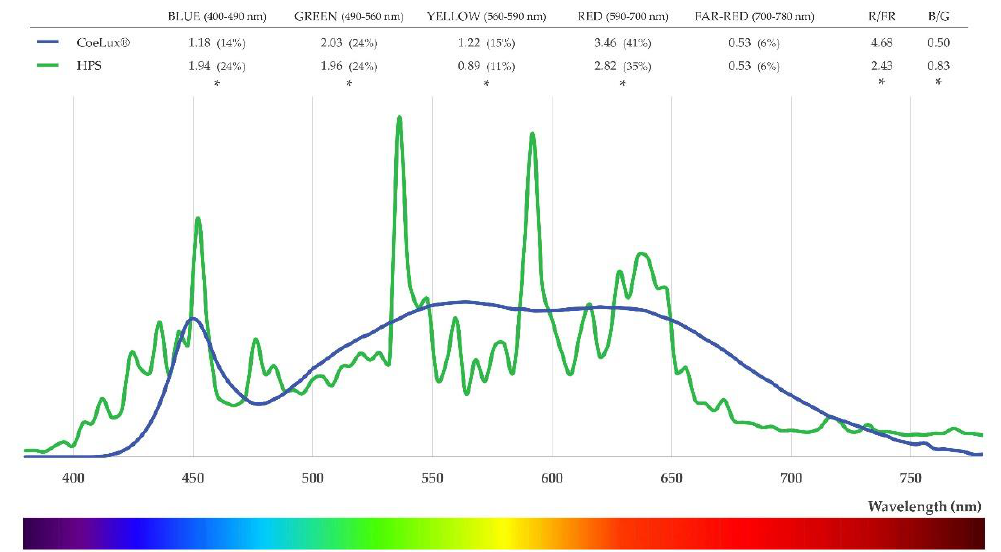
Figure 9. Mean light spectra curves collected within the CoeLux ® sunbeam (blue) and under HPS light (green). Color components mean values are reported and statistically significant differences are marked with an asterisk (*). R/FR: red-to-far-red ratio; B/G: blue-to-green ratio.